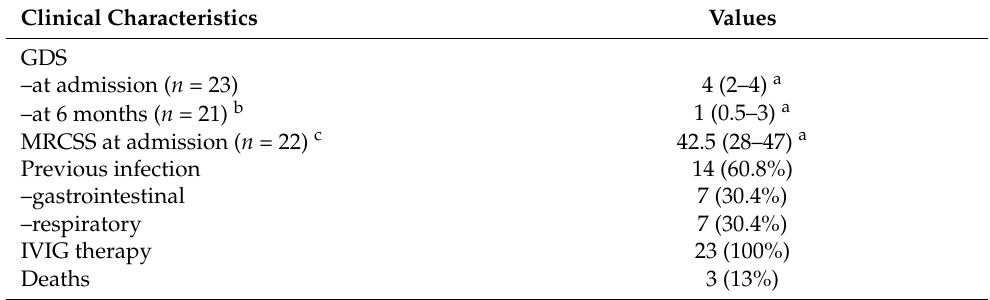
Table 1. Clinical characteristics of GBS